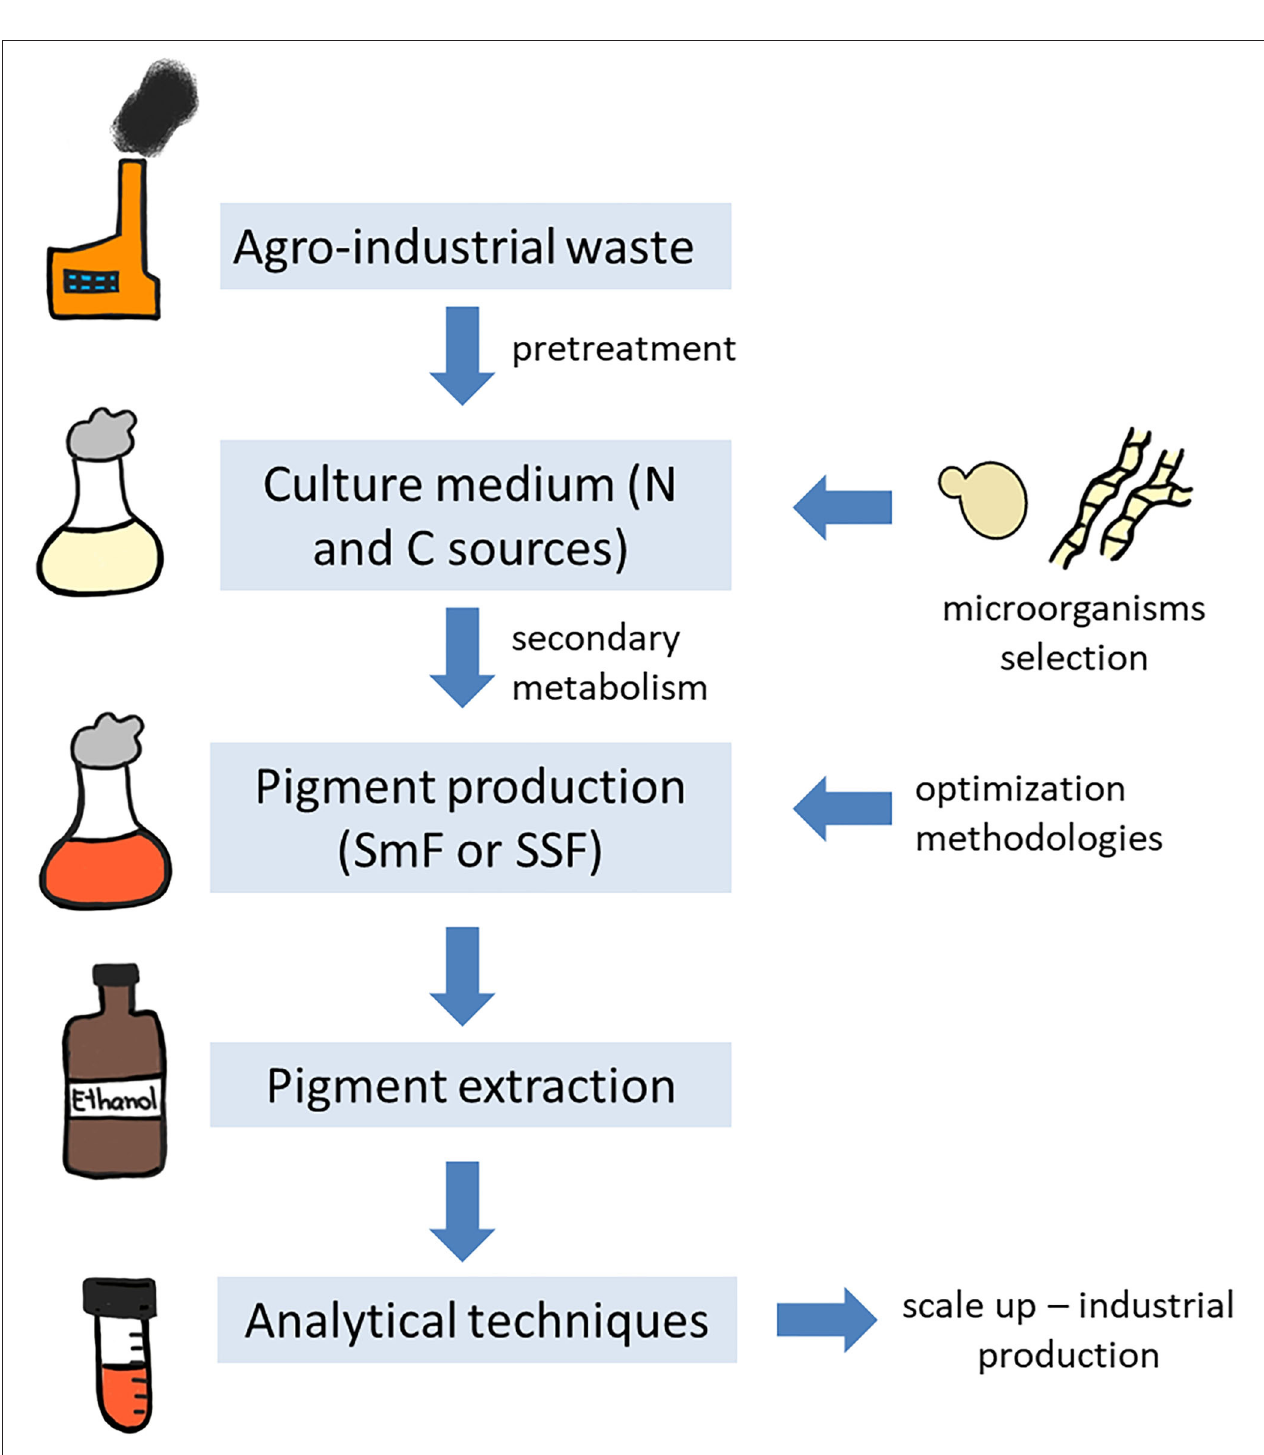
FIGURE 2 | Representative scheme of pigment production by microorganisms using agro-industrial residues.